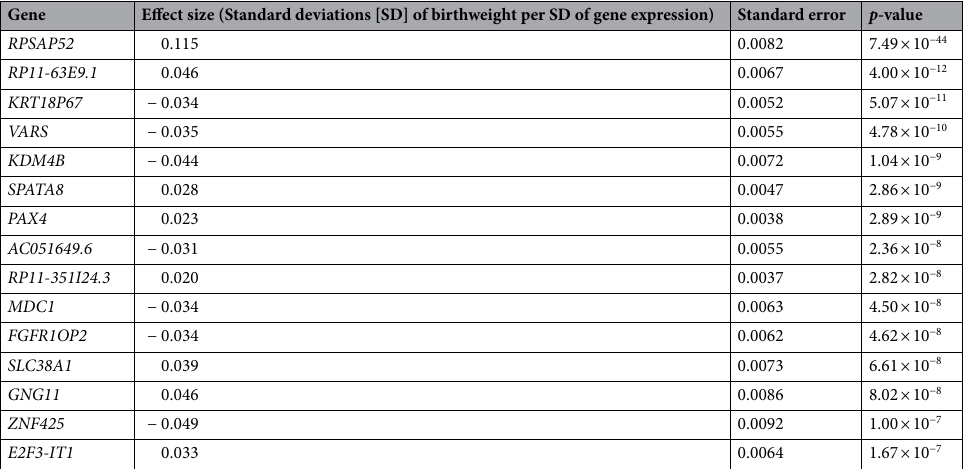
Gene Effect size (Standard deviations [SD] of birthweight per SD of gene expression) Standard error p